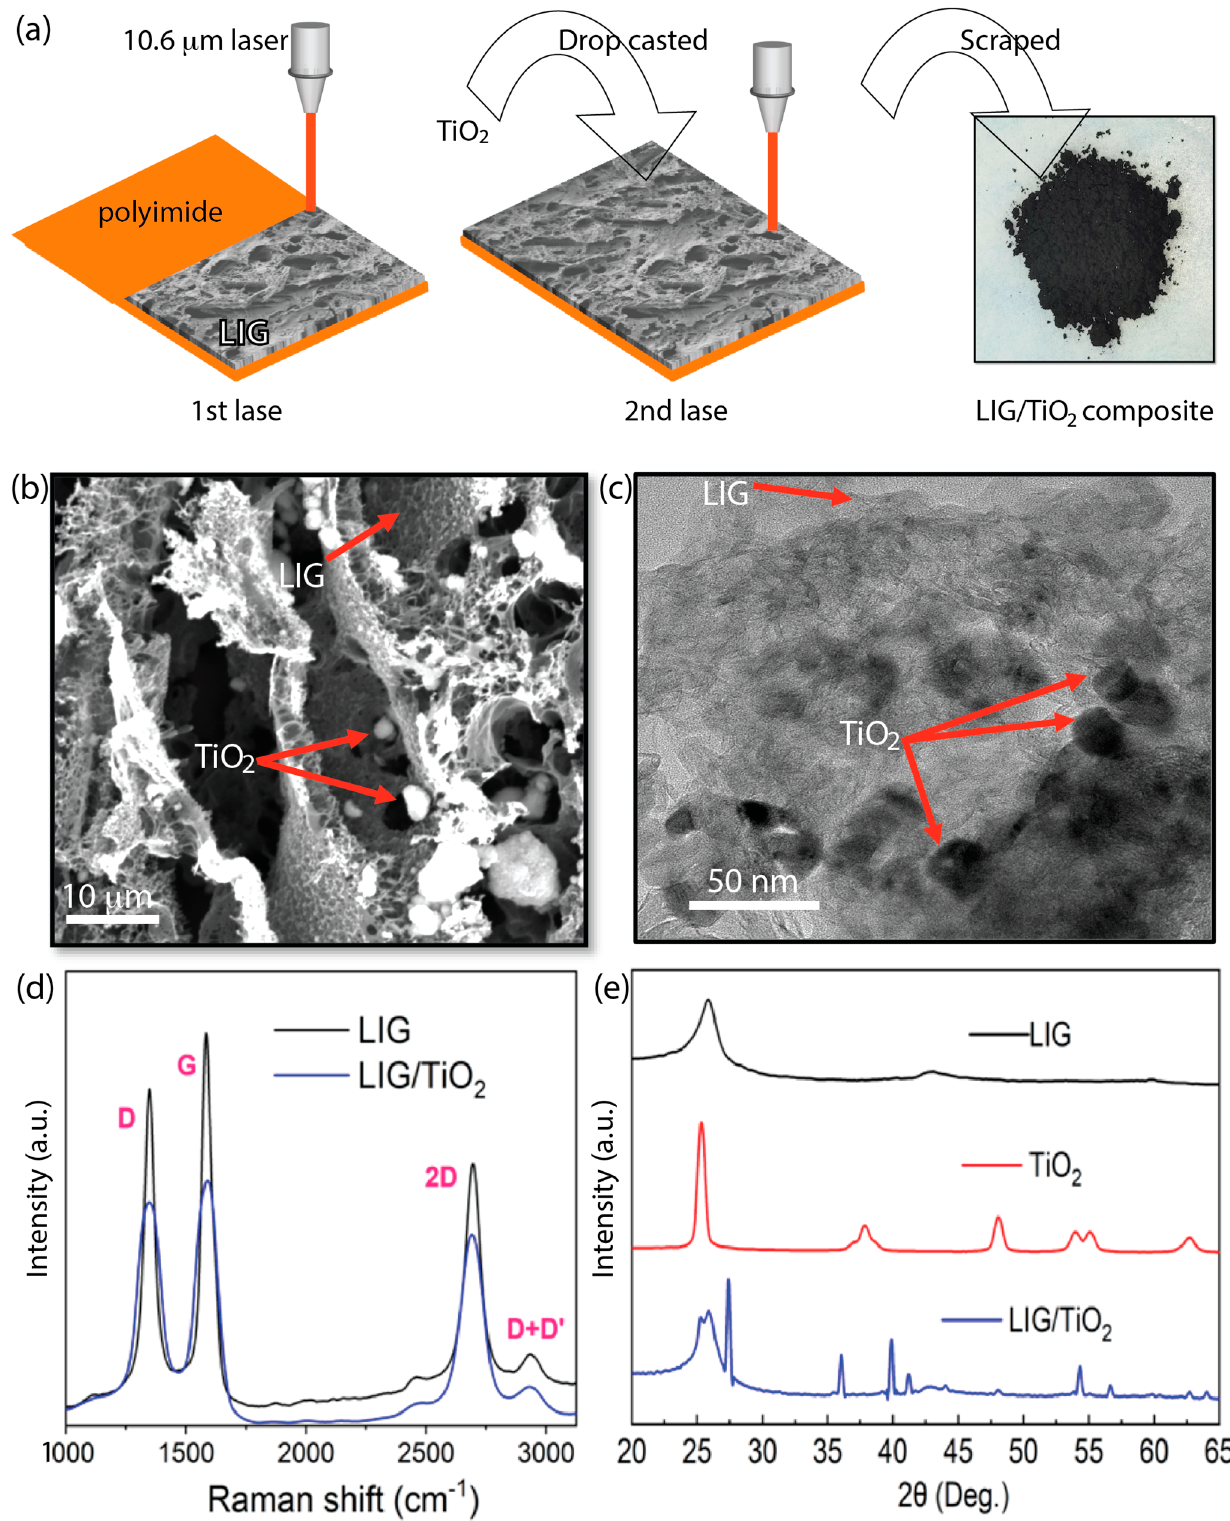
Figure 2. ( a ) Step by step fabrication of LIG/TiO 2 composite; ( b ) SEM image showing surface morphology of LIG/TiO 2 ; ( c ) TEM image of LIG/TiO 2 composite; ( d ) Raman spectrum of both LIG and LIG/TiO 2 showing D, G, 2D and D+D’ peaks; ( e ) X-ray diffraction (XRD) patterns of LIG, TiO 2 , and LIG/TiO 2